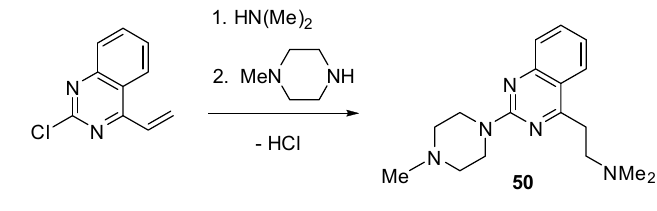
Scheme 5. Synthesis of quinazoline 50 .